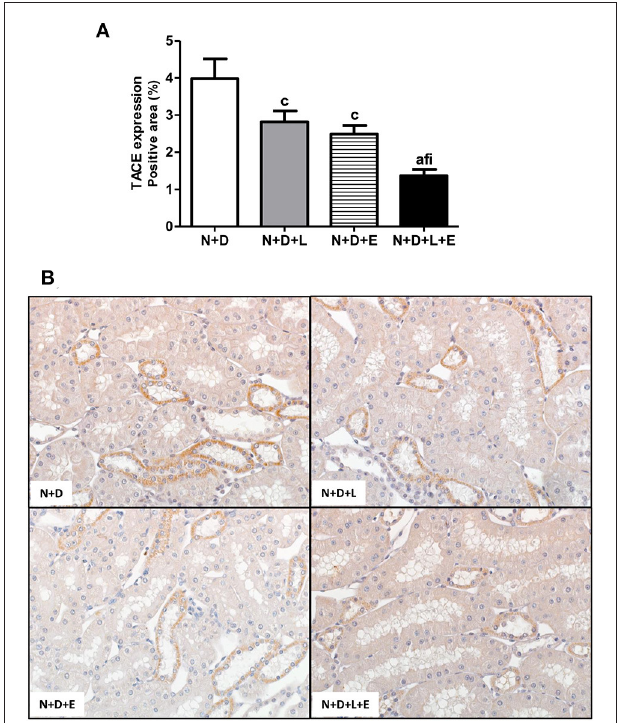
FIGURE 3 | Immunohistochemical analysis of tumor necrosis factor α -converting enzyme (TACE) expression in the renal cortex. (A) Bar graph of TACE expression evaluated 60 days after 5/6 nephrectomy in vitamin D-deficient rats treated with losartan, erlotinib or losartan + erlotinib. (B) Representative photomicrographs of immunostaining for TACE in the renal cortex from a N + D, N + D + L, N + D + E, and N + D + L + E rat (x400). Note that TACE expression is significantly lower in the N + D + L + E than in the other groups. Data are mean ± SEM. a p < 0.001, c p < 0.05 vs. N + D; f p < 0.05 vs. N + D + L; i p < 0.05 vs. N + D + E. N, 5/6-nephrectomized rats; D, vitamin D-deficient rats; L, losartan-treated rats; E, erlotinib-treated rats; L + E,